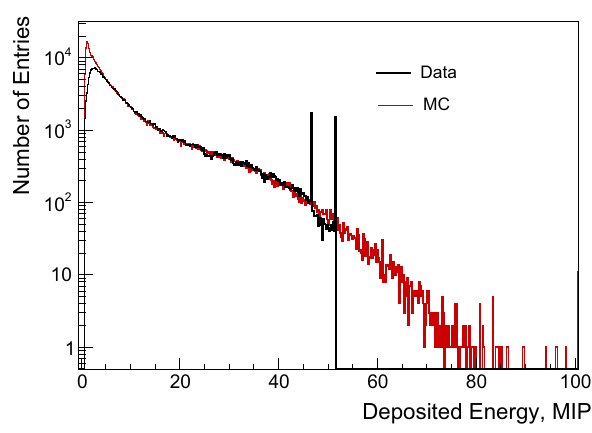
Fig. 14 Efficiency of signal identification as a function of the signal amplitude. Green triangles are measured for different channels, the red line is an average of the fit using Eq. (3) to a large number of channels, andtheshadedareacorrespondstothespreadoffitsatsmallamplitudes